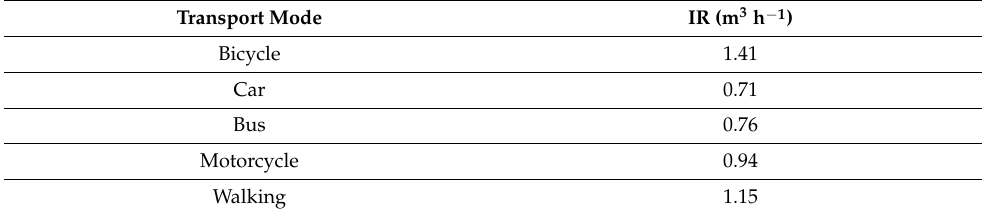
Table 3. Inhalation rate (m 3 h − 1 ) applied in the ExpoLIS app for each transport mode.